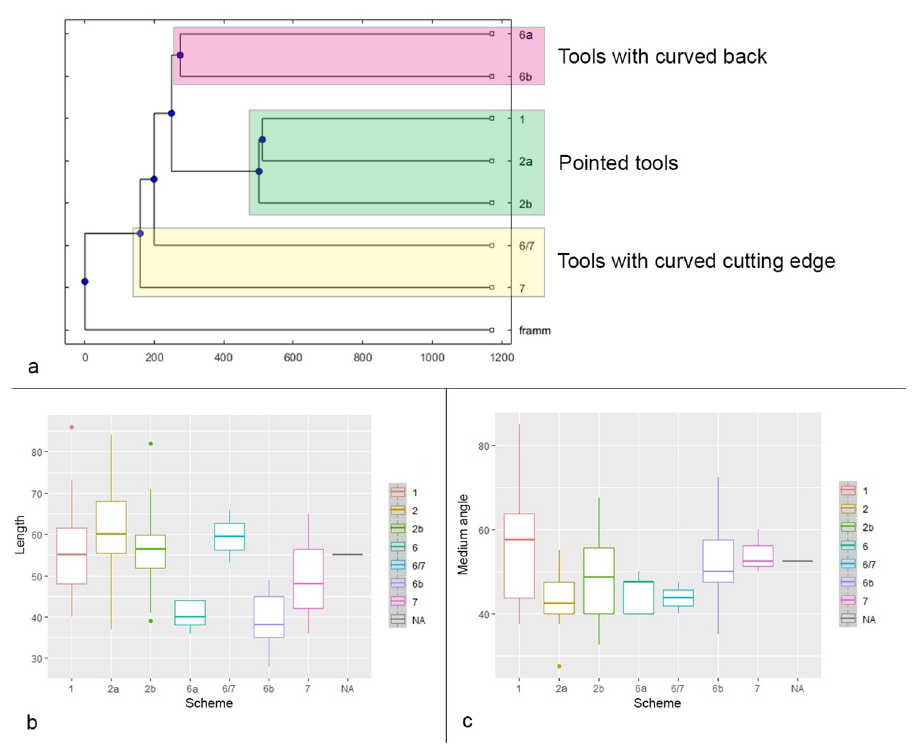
Fig 15. Variability between Keilmesser techno-functional schemes showed by group distance (a), length (b) and medium angle (c).